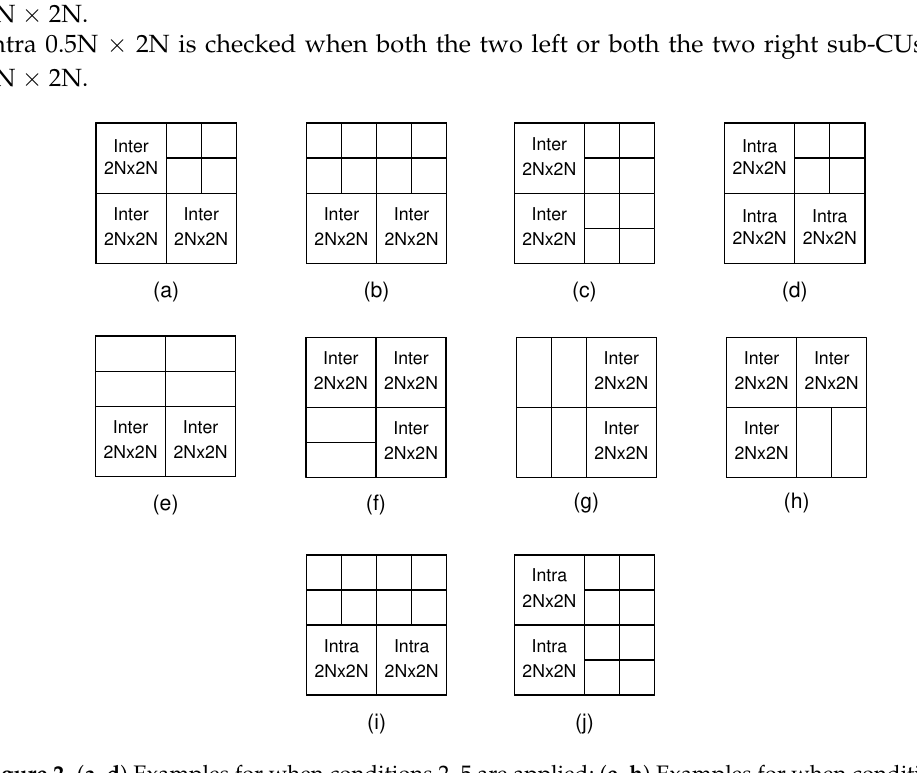
Figure 2. ( a – d ) Examples for when conditions 2–5 are applied; ( e – h ) Examples for when conditions of Asymmetric Motion Prediction (AMP) modes are applied; ( i , j ) Examples for when conditions of Short Distance Intra Prediction (SDIP) modes are